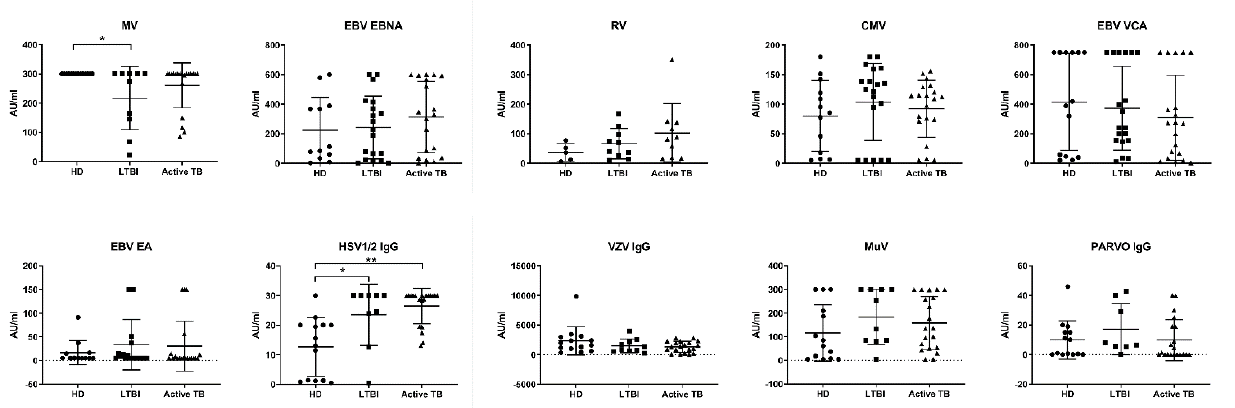
Figure 6. Quantitative analysis of preexisting IgG antibody titers to ten different common pathogenic viruses (MV, EBNA, RV, CMV, VCA, EA, HSV, VZV, MuV, PV), performed by ELISA assay; each dot represents one individual subject out of 20 LTBI, 20 Active TB, and 15 HD. The bars represent the mean and SD of each group. The significance of differences between groups was compared using the Kruskal–Wallis test; * p < 0.05, ** p < 0.01.